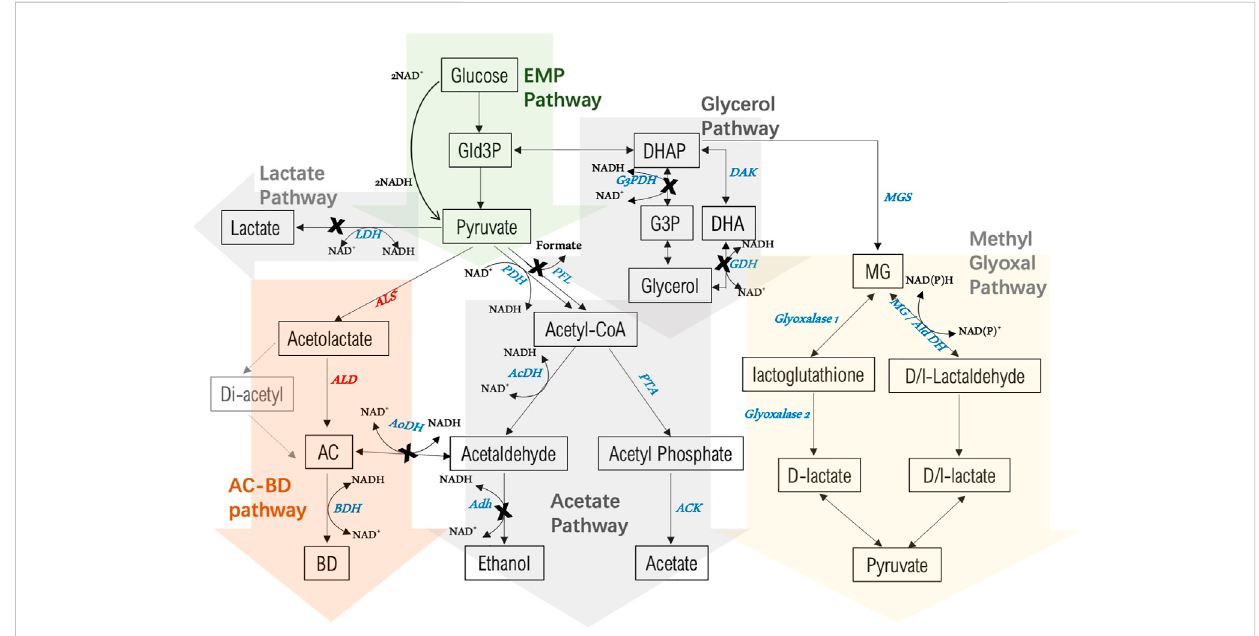
FIGURE 3 Overviewof2,3-BDObiosynthesis and by-product pathways in P. thermoglucosidasius NCIMB 11955 starting fromglucose asasubstrate. Enzymes involvedin2,3-BDObiosynthesisareinred:ALS:acetolactatesynthase;ALD:acetolactatedecarboxylase;BDH:2,3-butanedioldehydrogenase.Enzymes of competing pathways are in blue: LDH: lactate dehydrogenase; G3PDH: glycerol-3-phospahte dehydrogenase; DAK: dihydroxyacetone kinase; GDH: glycerol dehydrogenase; AcDH: Acetaldehdyde dehydrogenase; AoDH: Acetoin dehydrogenase; Adh: alcohol dehydrogenase; PTA: phosphate acetyltransferase; ACK: acetate kinase; MGS: methylglyoxal synthase; AldDH: aldehyde dehydrogenase. A cross indicates where the encoding gene has been deletion in the present study. AC = acetoin, BD =